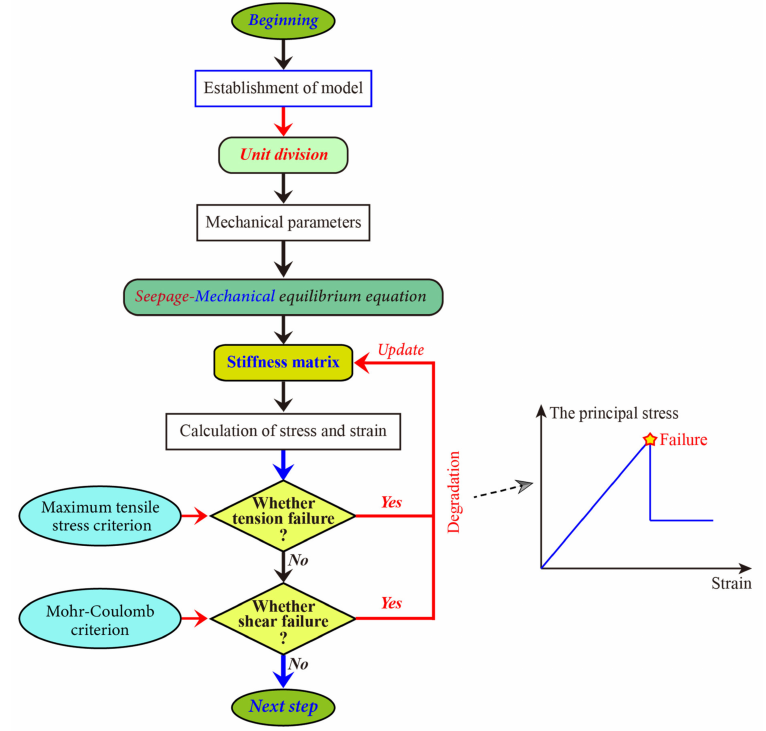
Figure 3. Flow chart of numerical simulation